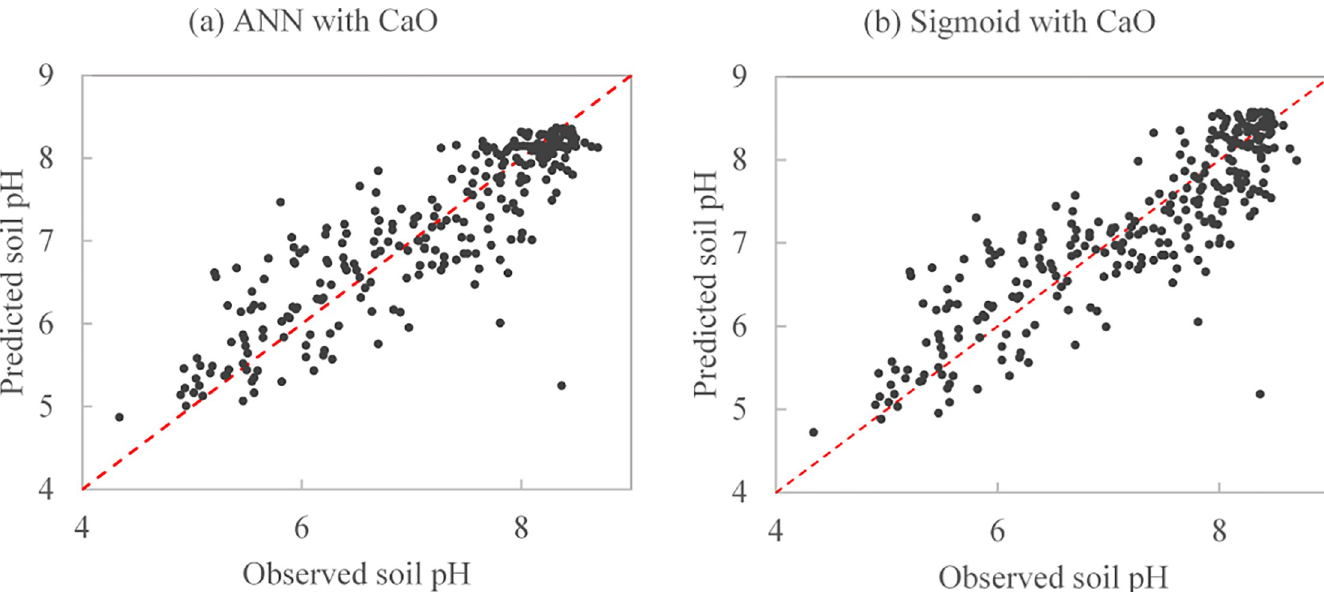
Fig 6. Scatter plot of the observed and predicted soil pH by (a) artificial neural network with CaO and (b) sigmoid with CaO. The red dash line is the 1:1 line.